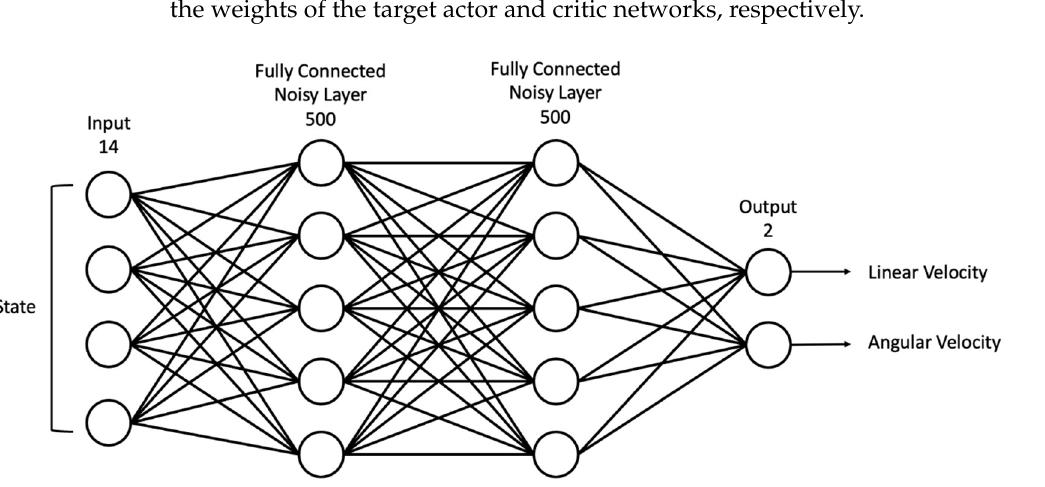
Figure 4. Critic network structure consisting of fully connected layers.